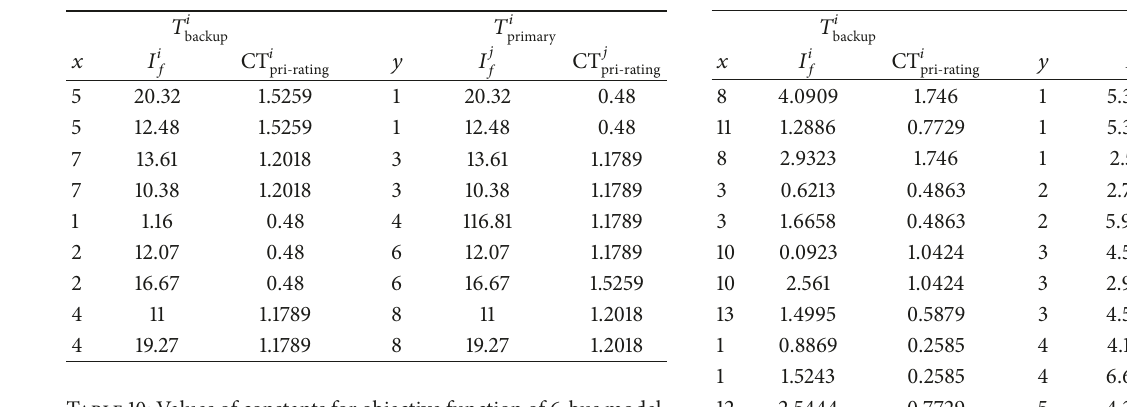
Table 9: Values of constants for 𝑇